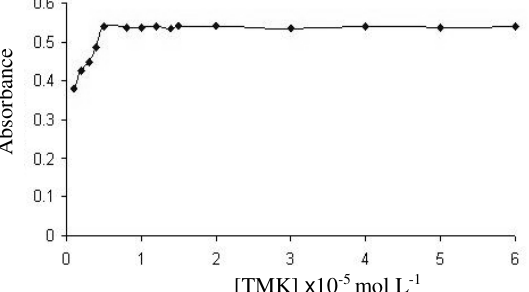
Figure 2. Effect of TMK concentration on the absorbance of the complex.